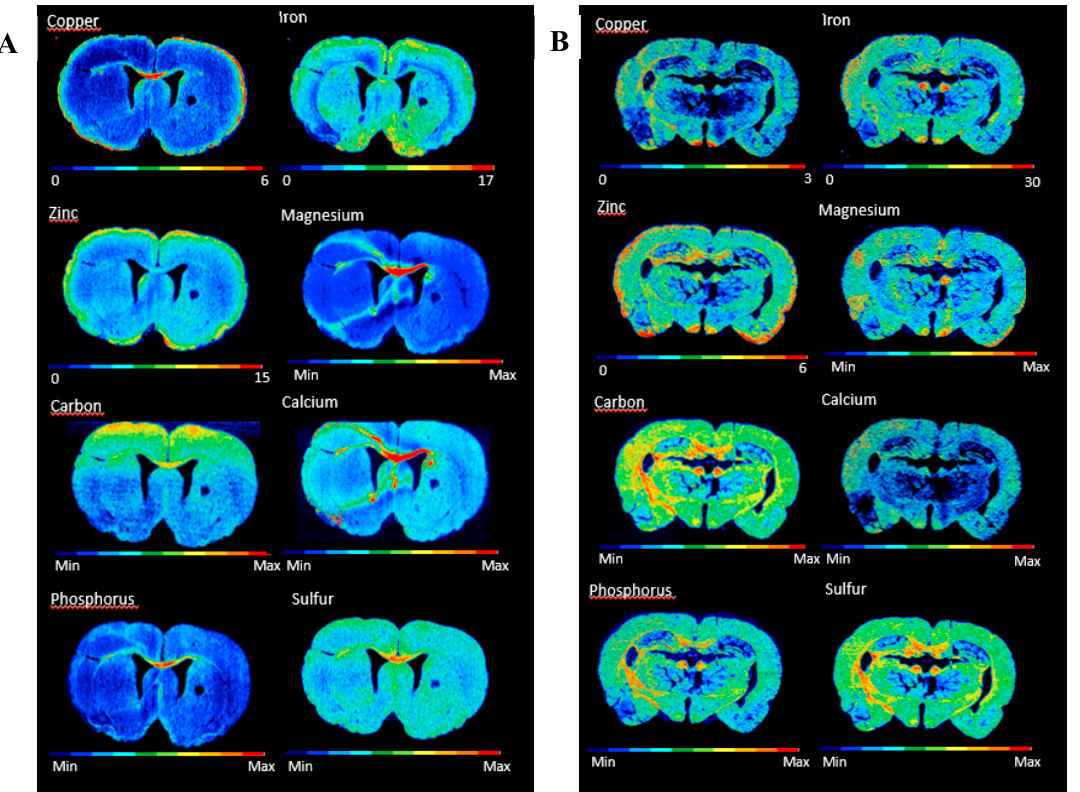
Figure 6. Distribution of the elements: ( A ) Cu, Fe, Zn, Mg, C, Ca, P, and S in the rostral, and ( B ) the caudal part of rat brain sections. The color bar represents a high-concentration, in red, and a low-concentration, in blue.